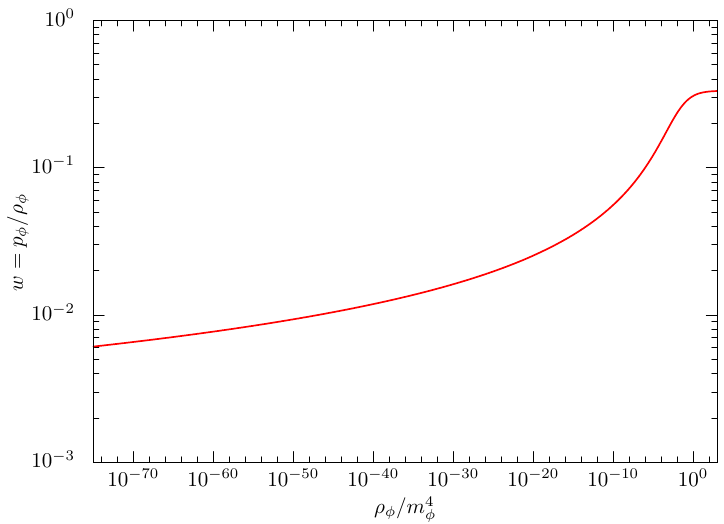
Figure 3. Relation between the energy density and the pressure for the self-thermalized φ